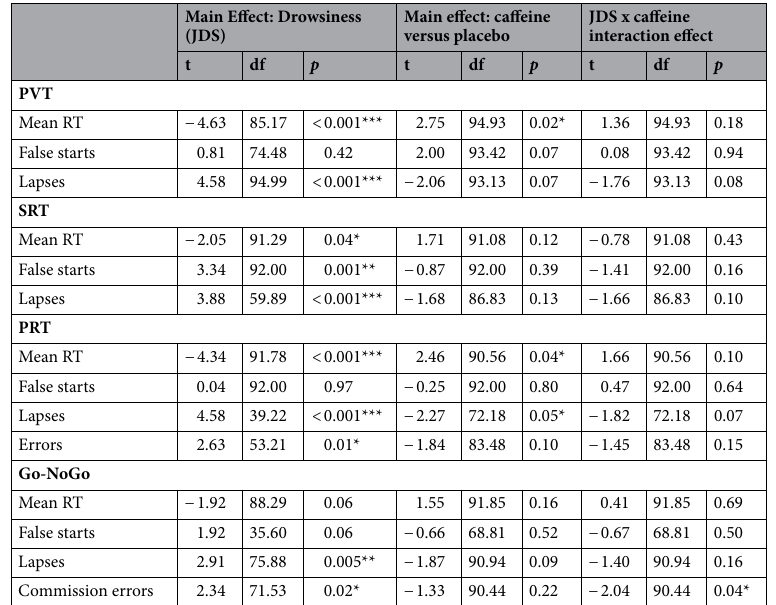
Table 1. Effects of drowsiness (JDS), caffeine ( n = 4 vs. placebo, n = 6) and their interaction on task performance in simple reaction (PVT and SRT), procedural reaction (PRT) and response inhibition (Go-NoGo) tasks. Notes: Non-integer df values are the result of effect size estimation with Satterthwaite approximated t statistics derived from mixed linear modelling analyses. RT reaction time, PVT only post-driving PVT data are presented that could be matched to preceding JDS scores. * p < 0.05; ** p < 0.01; *** p <